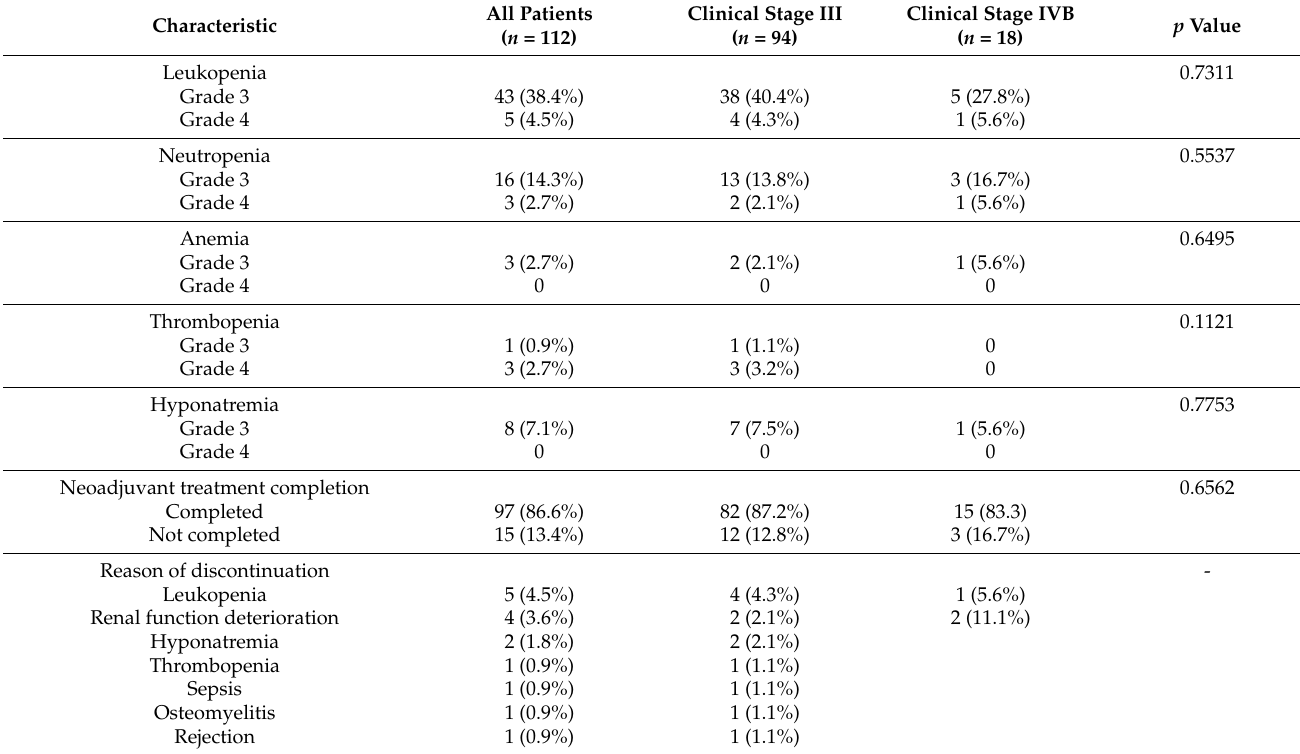
Table 3. Adverse events and reasons for discontinuation during